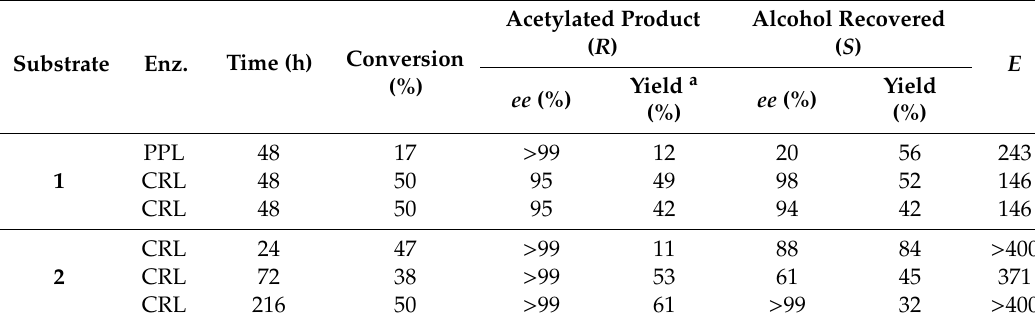
Table 1. Results of lipase-mediated